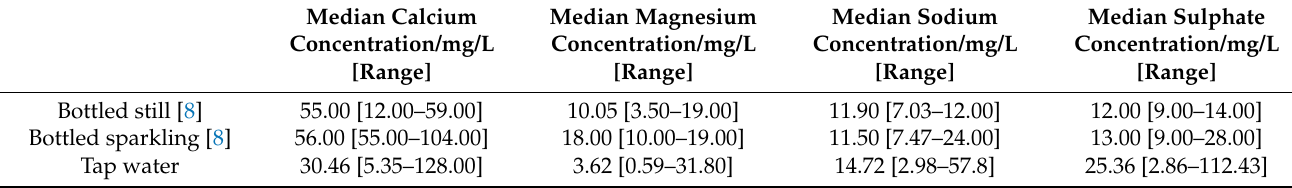
Table 4. Comparison of bottled and tap water in the United